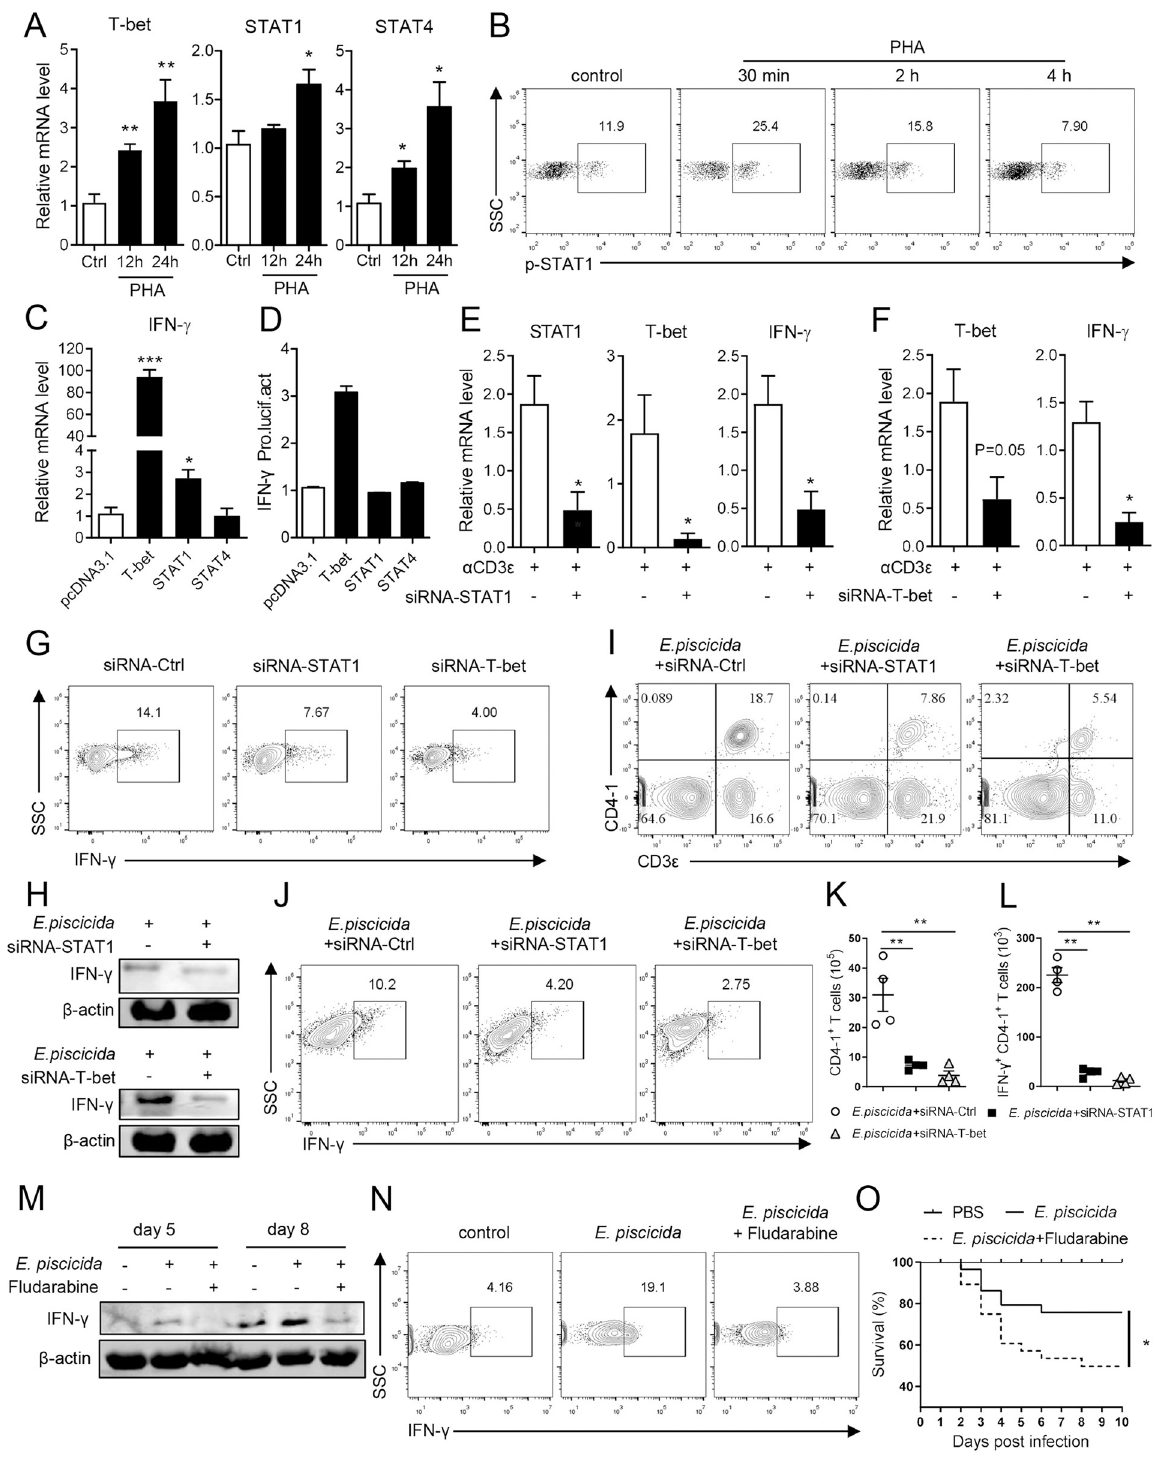
Fig 5. STAT1/T-bet axis regulates the Th1 differentiation in tilapia. ( A ) Spleen leukocytes were stimulated with PHA for 12 h. Relative mRNA levels of T-bet, STAT1 and STAT4 were examined by qPCR, n = 4. ( B ) Flow cytometry showed the phosphorylation level of STAT1 in lymphocytes that stimulated with PHA. ( C ) Transcriptional levels of IFN- γ in HEK 293T cells that transfected with tilapia T-bet, STAT1 and STAT4, n = 6. ( D ) HEK 293T cells were co-transfected with tilapia T-bet, STAT1 or STAT4, and pGL3-IFN- γ promoter. The LUC activities were assessed at 48 h post-transfection, n = 4. ( E-G ) Spleen leukocytes from tilapia that i . p . injected with T-bet-specific, STAT1-specific or control